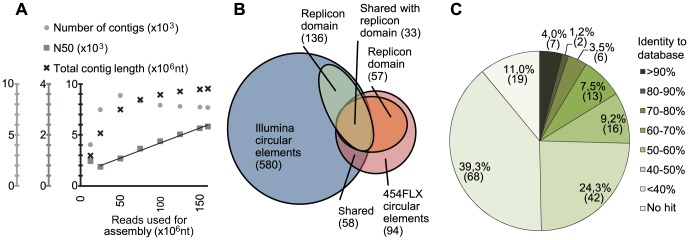
Rarefaction plot and circular elements composition.A, rarefaction estimation of sequencing depth by assembly of random subsets of Illumina PE read pairs. Crosses show total contig length as a function of subset size. The saturation that can be seen after the 50(R2  =  0.99), suggesting that information on assembly of contigs are not exhausted. Circles show contig number as a function of reads used for assembly. Notably, fewer contigs are found with larger subset sizes, suggesting that contigs have been joined as little total contig length s added. B, Diagram of circular sequences found in the Illumina and 454 dataset. In total, 616 sequences were found to be circular. Of these, 160 sequences had 173 predicted genes with replicon domains. C, identity between replicon domain genes from putative plasmids and the best BLAST hit in the plasmid database. Binning of the BLAST hits by identity percent reveals that few replicon domain genes are similar to database versions while many are very different from database versions. Thus, 50.3% of replicon domain genes have less than 40% sequence identity to database version while 8.7% of replicon domain genes in the putative plasmids have more than 70% identity.